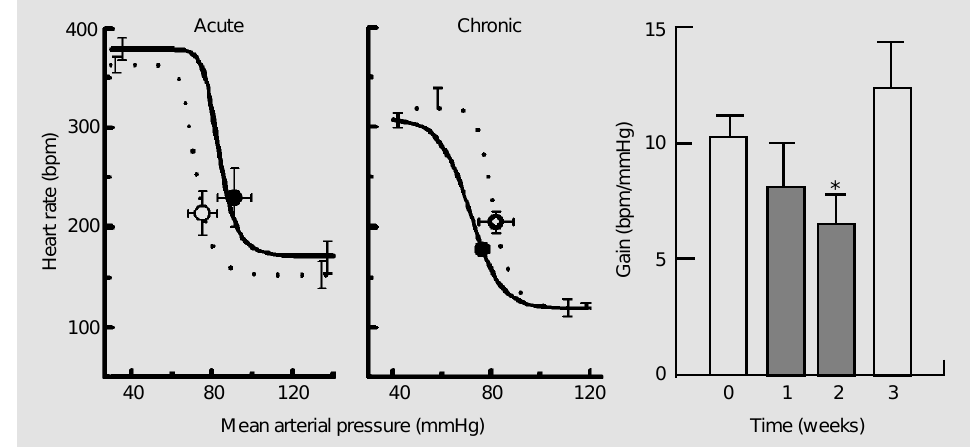
Figure 3. Cardiac baroreflex curves before and after acute (4 pmol/min) or chronic (100 ng/h for 2 weeks) fourth ventricle (4V) infusion of Ang II in con- scious rabbits (left and middle panels). Dotted line - control, black line - Ang II. Right panel , Gain of the cardiac baroreflex before (week 0, left open bar), during (weeks 1 and 2, gray bars) and after (week 3, right open bar) 2-week 4V infusion of Ang II (100 ng/h). *P<0.05 for comparison between control and treatment. Error bars are average SEM. Figures adapted with permission from